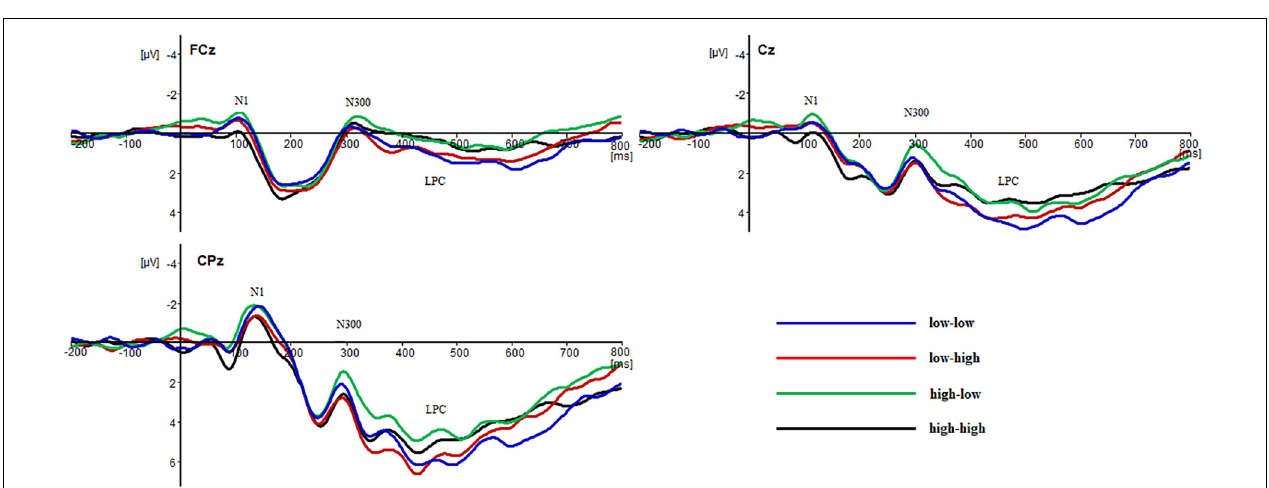
FIGURE 2 | The grand average of event-related potentials (ERP) elicited for the four Bayesian reasoning